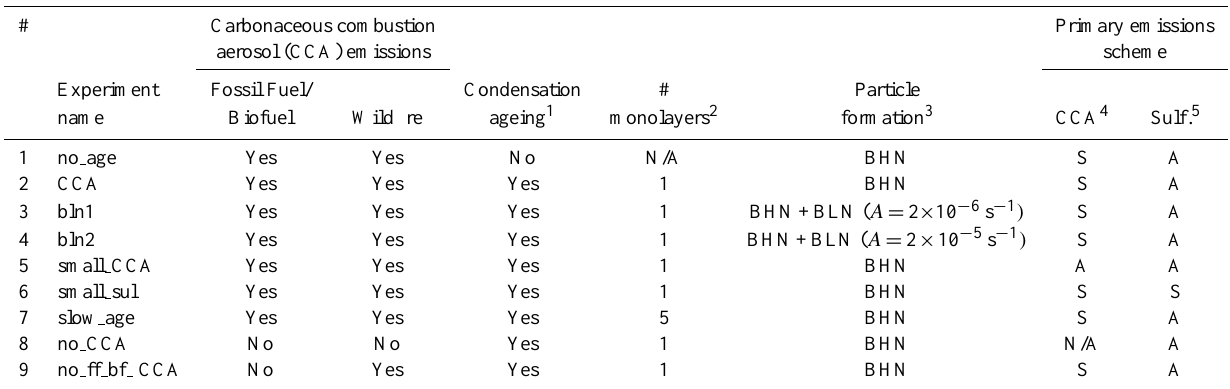
Table 3. Details of GLOMAP model